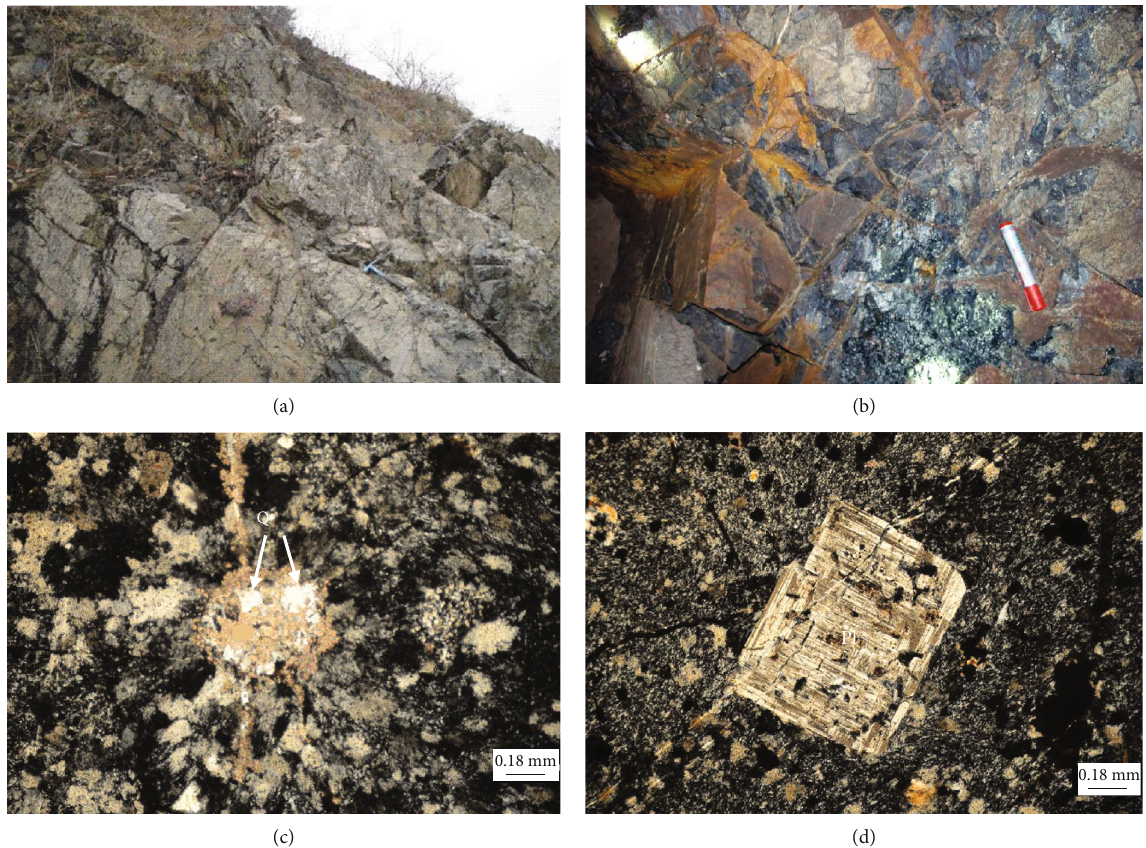
Figure 3: Field and micrographs of the Jidanping Formation in the Xiong ’ er Group. (a) Field surface outcrop of dacite. (b) Dacite outcrop in Jiuzhanggou gold mine. (c) Micrograph of dacite. (d) Feldspar phenocryst of